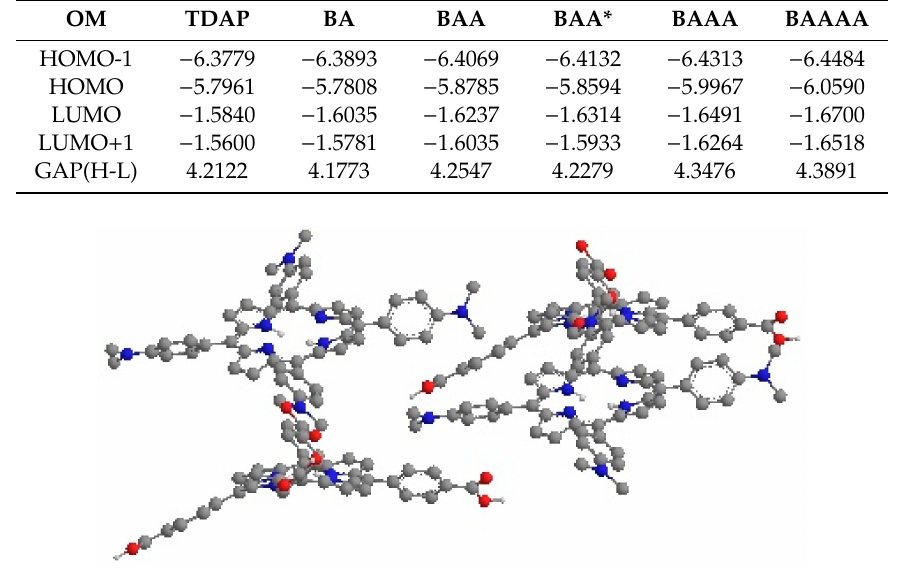
Scheme A1. Side view of the structural molecular model proposed in Figure 5C, emphasizing the saddling